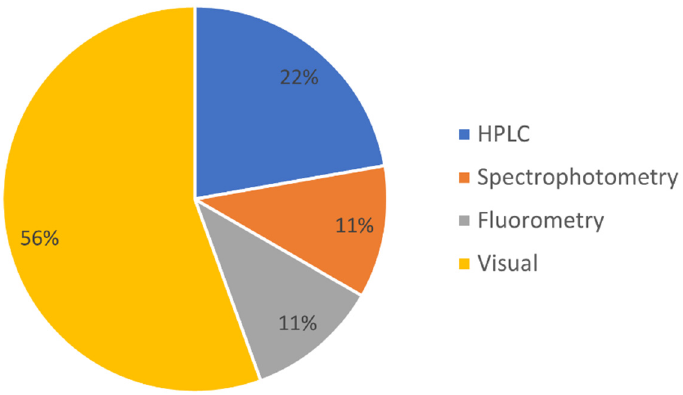
Figure 6. Summary statistics of validation or regression methods employed in UHI studies. Pigment extraction has been performed using high-performance liquid chromatography (HPLC), spectrophotometry, and fluorometry to derive pigment content such as Chl a . Visual refers to the manual annotation of seafloor objects or features of interest.